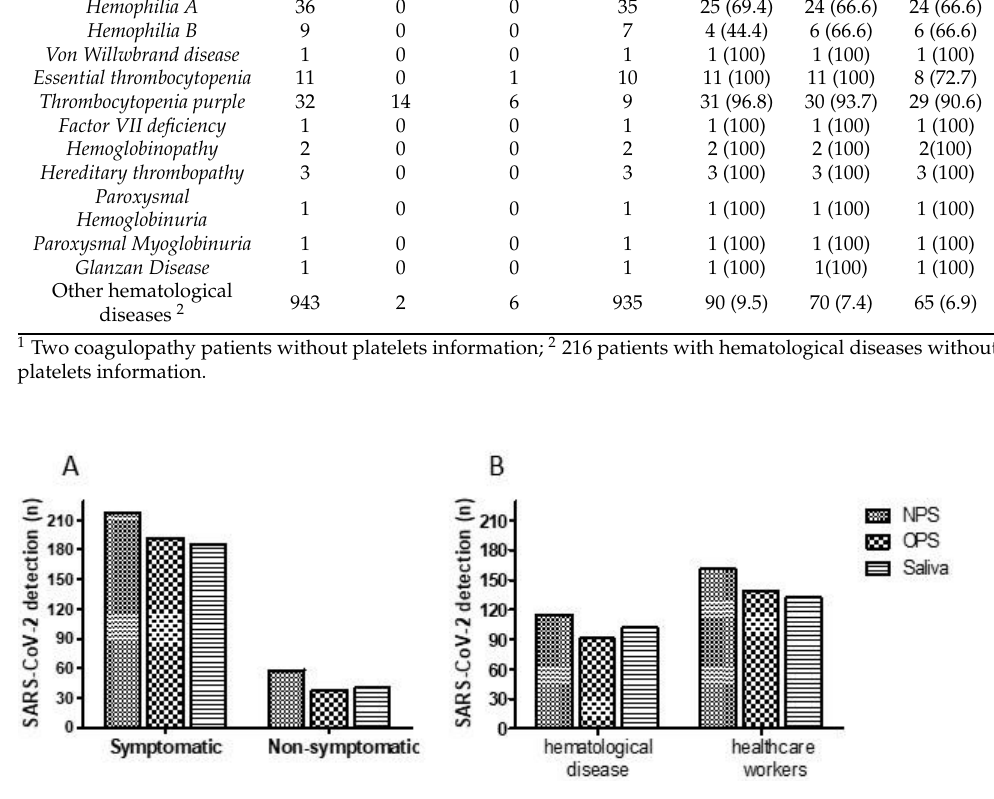
Figure 1. SARS-CoV-2 detection according to the studied population. ( A ) SARS-CoV-2 detection according to the presence of symptoms. ( B ) SARS-CoV-2 detection between patients with hematological disease and healthcare workers. NPS: nasopharyngeal swab, OPS: oropharyngeal swab. Table 3. Comparison of SARS-CoV-2 detection in saliva, NPS and OPS according to clinical characteristics of the population.